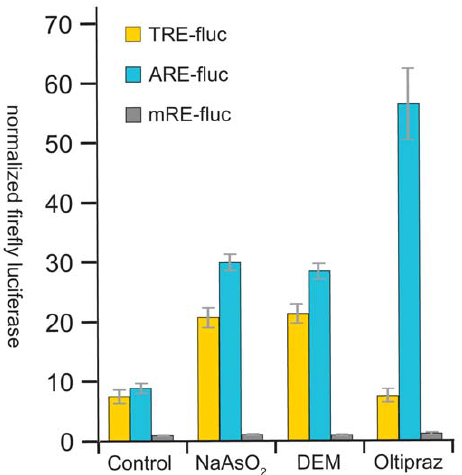
Figure 6. Stimulation of cell-based reporters by sulforaphane, oltipraz and stressors. S2 cells transiently transfected with TRE-fluc, ARE-fluc or mRE-fluc plasmids, as indicated, were exposed to sodium arsenite (NaAsO 2 ), Diethyl Maleate (DEM) or oltipraz. The firefly luciferase activity was measured 24 hrs after drug treatment and normalized to renilla luciferase activity expressed from a co-transfected Act5C renilla luciferase construct. Note that both TRE and ARE reporters respond to the stressors, Arsenite and DEM, but only ARE-fluc responds to Oltipraz. The mRE reporter responds neither to oltipraz nor to the stressors. The activity of mRE-fluc reporter under control conditions was set to 1. Error bars indicate standard deviation of triplicate measure-